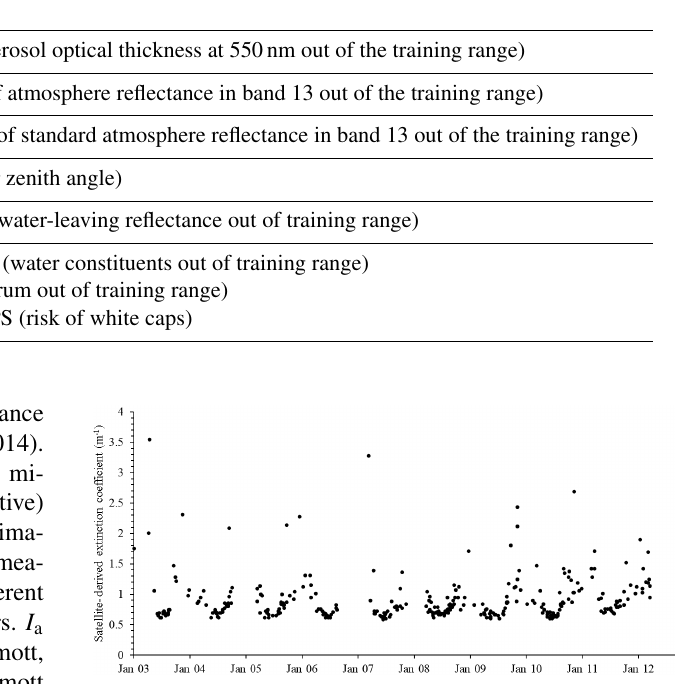
Figure 2. Variations of CoastColour-derived K d for the selected lo- cation during the study period